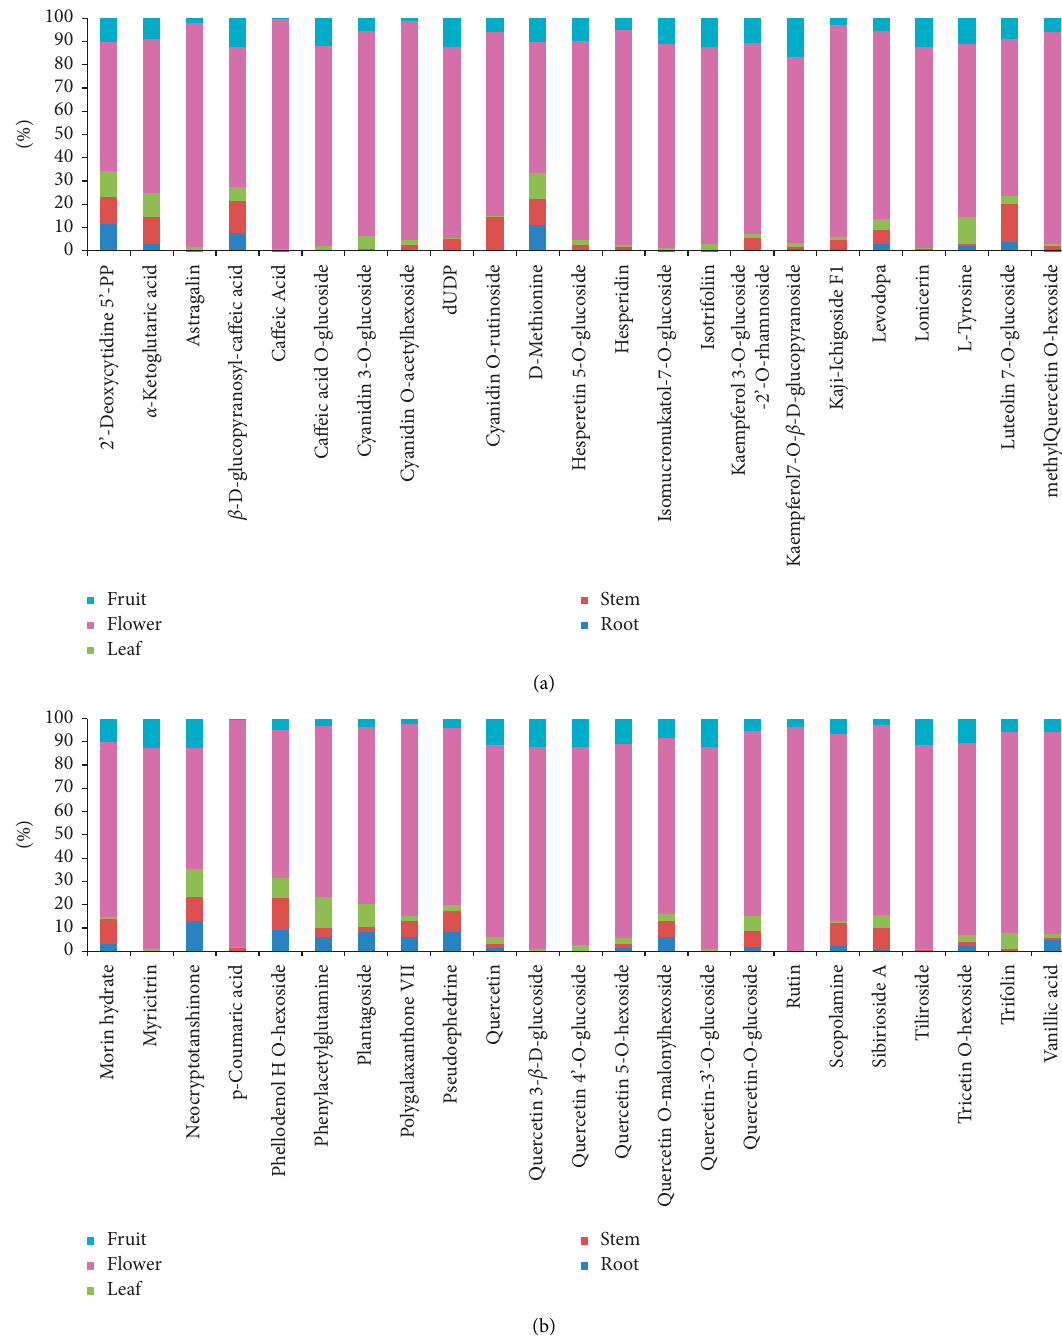
2 (Flower/Root), Log 2